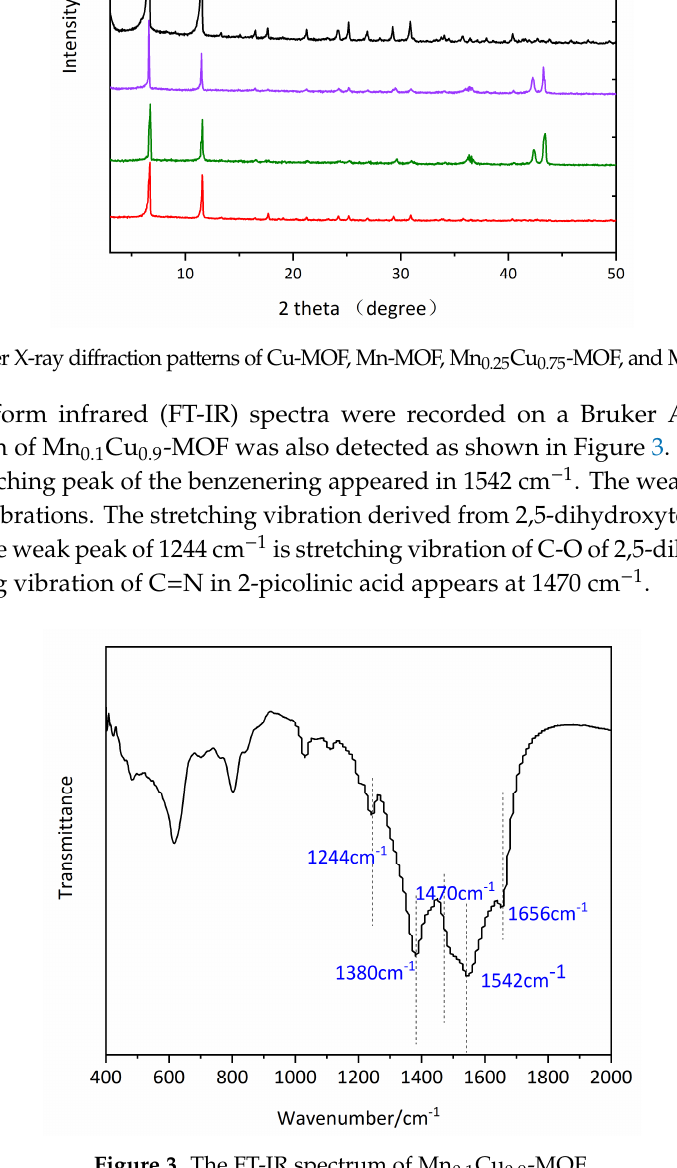
Figure 3. The FT-IR spectrum of Mn 0.1 Cu 0.9 -MOF.